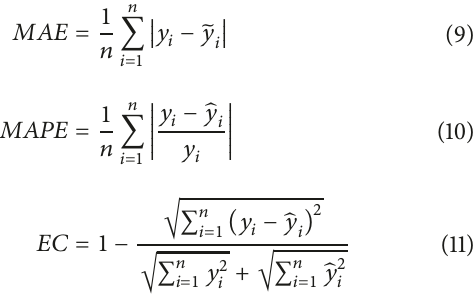
Figure 11: The forecasting performance of detector NBXX10 (1)